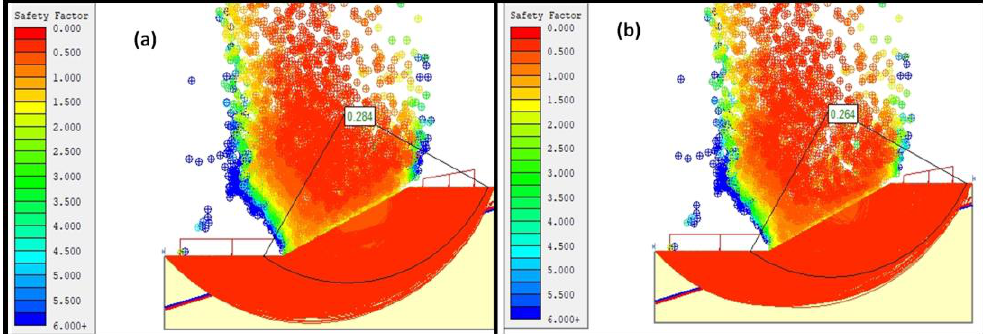
Figure 19. Safety factor simulated for rainy conditions in silt clay soil slope using ( a ) Bishop’s simplified method and ( b ) Janbu’s simplified